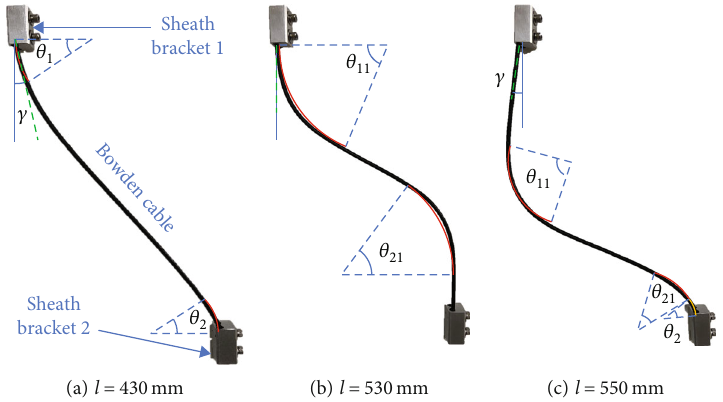
Figure 6: Various states with di ff erent lengths of Bowden cable in two sheath